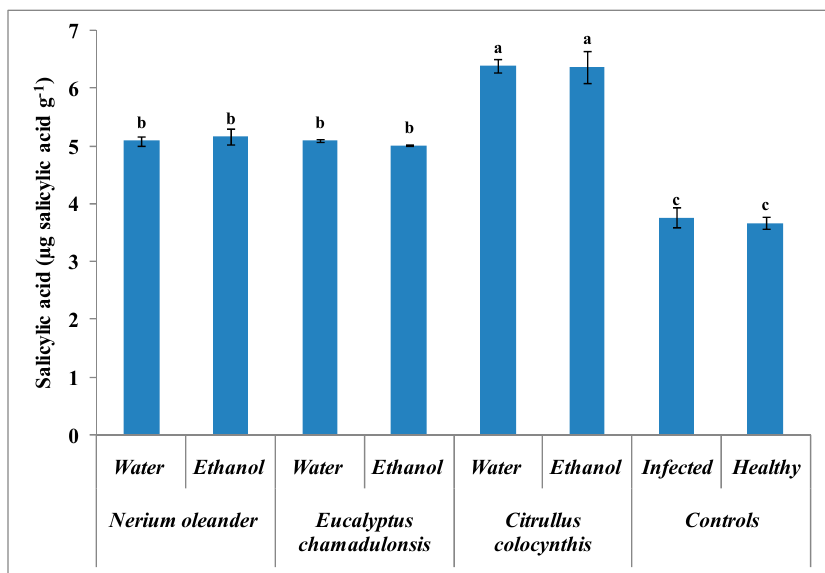
Figure 3. Effect of 15% concentrations of plant extracts of Nerium oleander, Eucalyptus chamadulonsis and Citrullus colocynthis on salicylic content of ‘Super Marmande’ tomato after 7 days of treatment with the extracts and inoculated with Xanthomonas axonopodis pv. vesicatoria PHYXV3. Four replicates were used for each treatment. Columns with the same letters are not significantly different according to Fisher’s protected least significant difference at p ≤ 0.05.